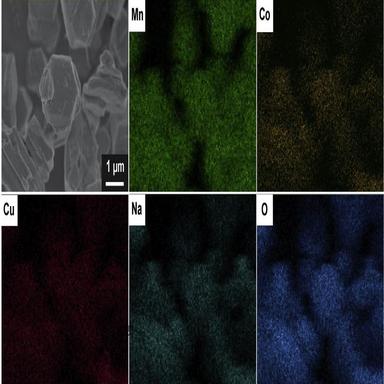
SEM image of the P2-MCC and the corresponding EDX elemental distributions of Mn, Co, Cu, Na and O.